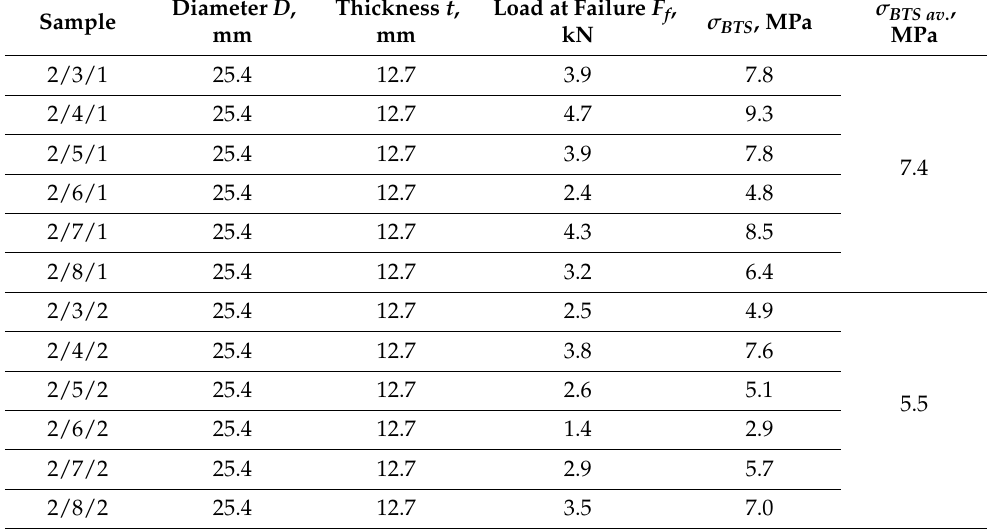
Table 2. Results of the indirect tensile tests of limestone geomaterial samples. Data on air-dried samples are in the top rows, and data on water-wet samples are in the bottom rows. Diameter D , Thickness t , Load at Failure F f Sample mm mm